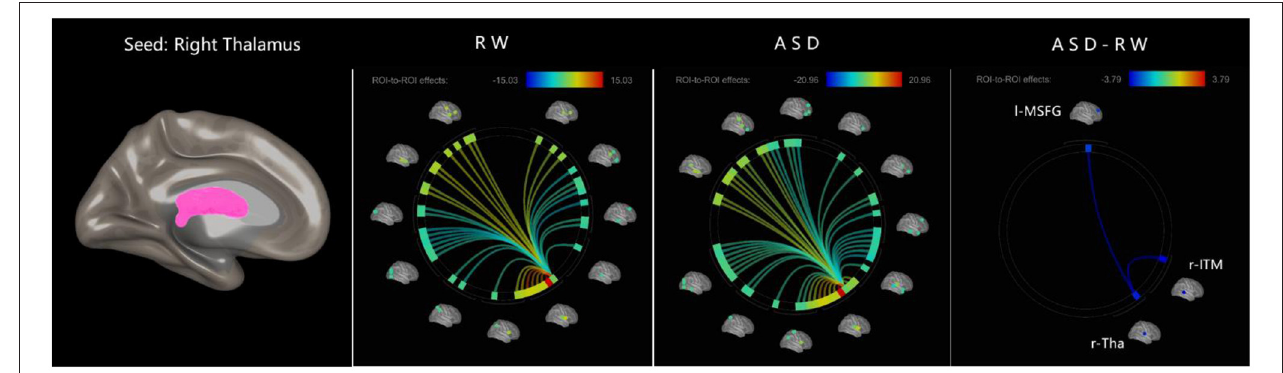
FIGURE 3 | ROI-to-ROI functional connectivity of left thalamus during RW, ASD, and ASD > RW conditions. False discovery rate-corrected ( p < 0.05) for ROI-to-ROI tests. The functional connectivity between r-Tha and r-ITM, l-MSFG decreased decreased during ASD. r-Tha, right thalamus; r-ITM, right middle temporal gyrus; l-MSFG, left medial superior frontal gyrus; ROI, region of interest; ASD, acute sleep deprivation; RW, rested